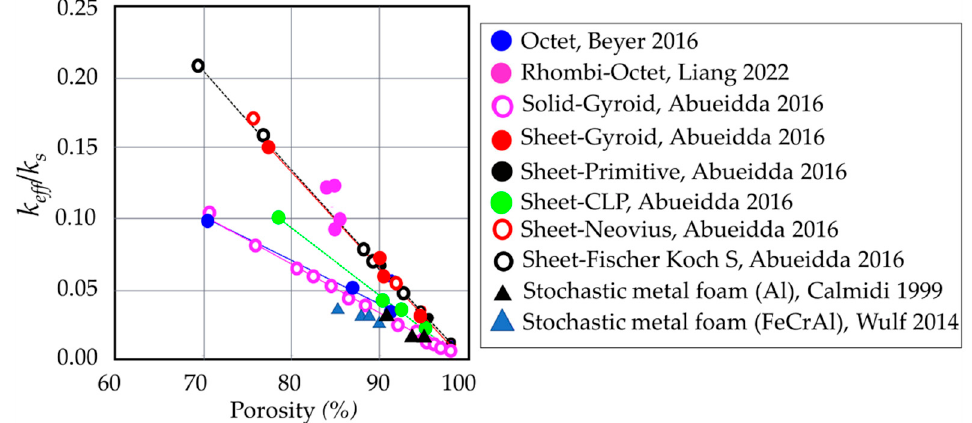
Figure 4. Demonstrations of the normalized thermal conductivity for different unit cell structures plotted against the porosity [2]. (k eff is the effective thermal conductivity, and k s is the thermal conductivity of the solid). Octet [10], Rhombi-Octet [13], Solid-Gyroid [36], Sheet-Gyroid [36], Sheet- Primitive [36], Sheet-CLP [36], Sheet-Neovius [36], Sheet-Fischer Koch S [36], Stochastic metal foam (Al) [39], Stochastic metal foam (FeCrAl) [40].